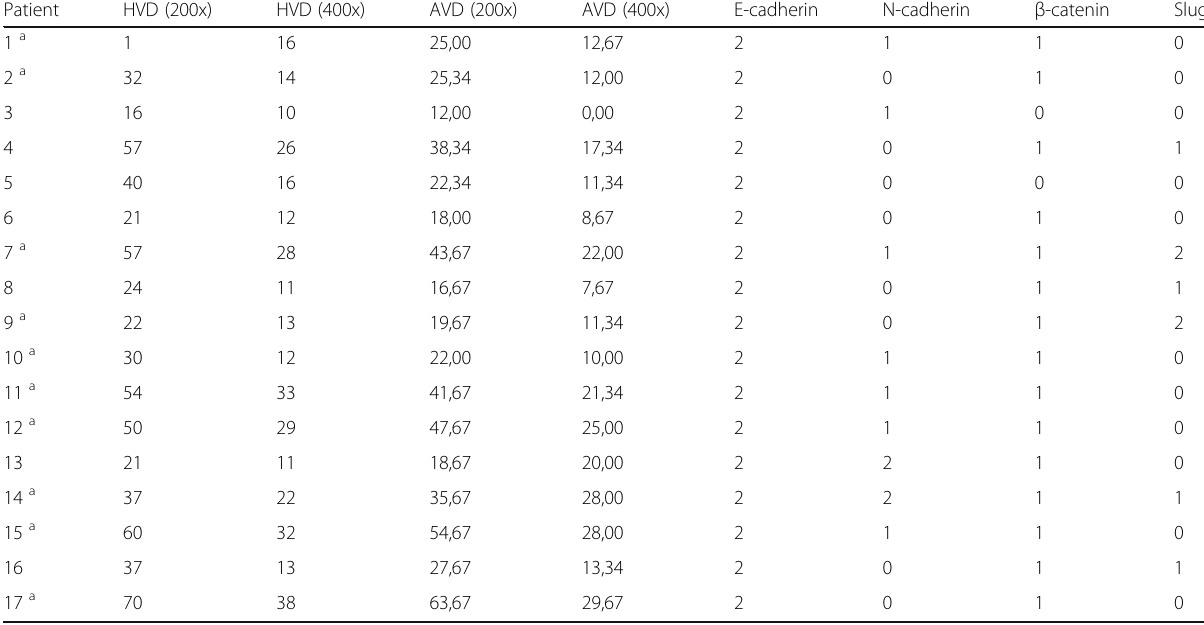
Table 2 Immunohistochemical findings of MVD and EMT- related markers